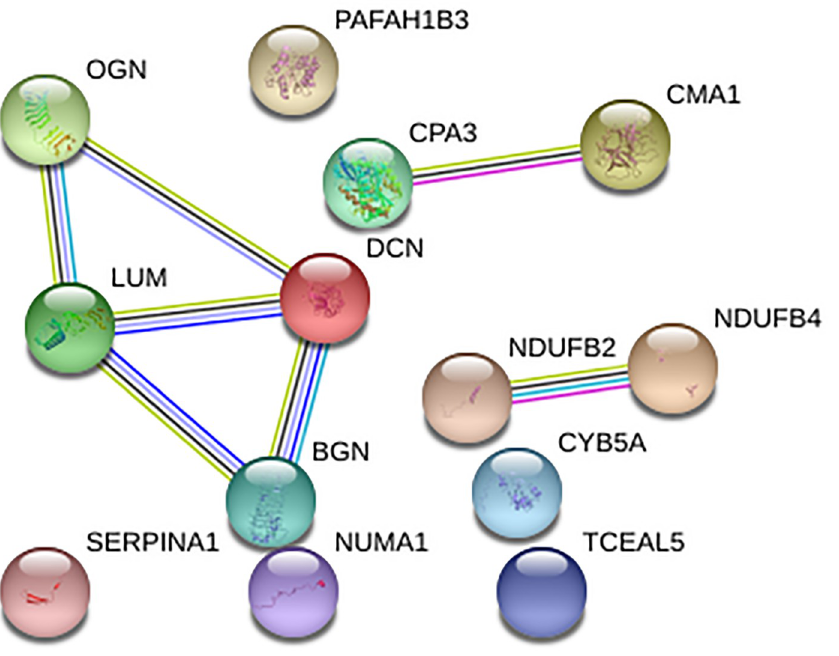
Fig 4. Network built with the proteins from Component13 using